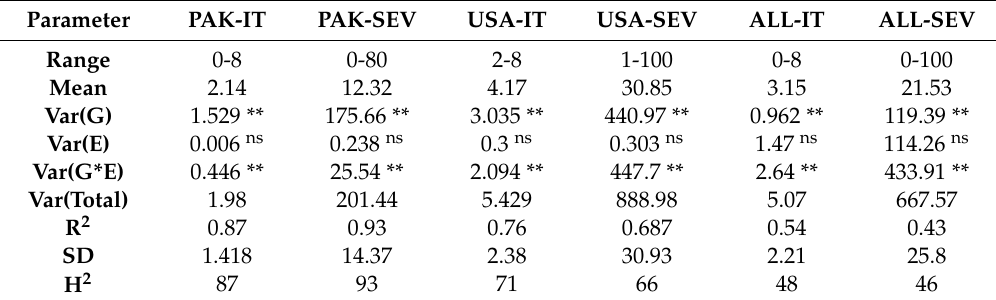
Figure 4. Infection distribution of 465 spring wheat genotypes at the adult plant stage and the stripe rust disease severity (SEV) score across three environments. Scoring for the adult plant response performed in three di ff erent environments (two years in Pakistan considered as one location and two locations in the USA). Table 1. Mean, range and the variance components of Puccinia striiformis under di ff erent